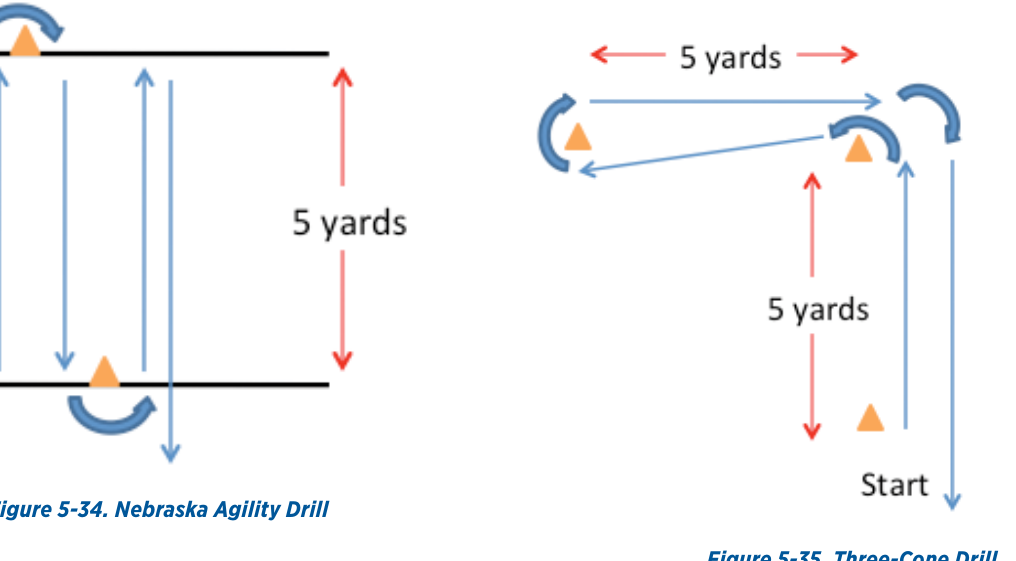
Figure 5-35. Three-Cone